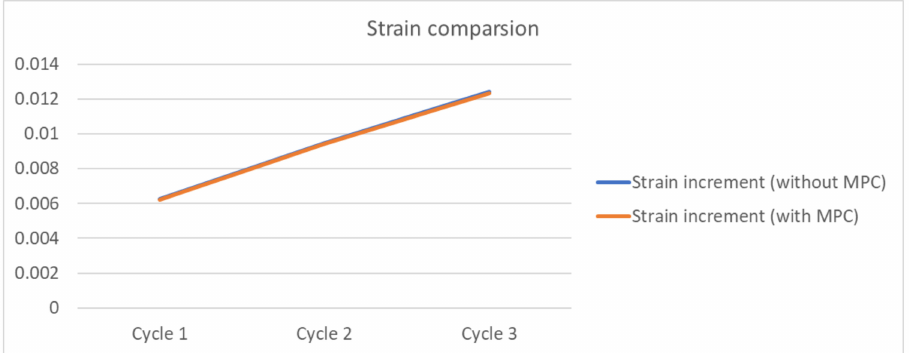
Figure 15. Strain increment in the full and MPC models.